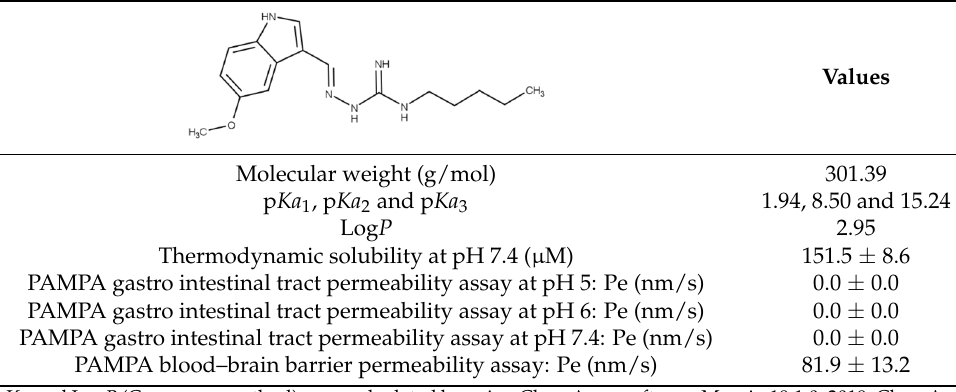
12 of 23 Figure 2. Neuronal survival and neurite network in a primary culture of cortical neurons injured with A β . * p < 0.05 versus A β 1–42 .